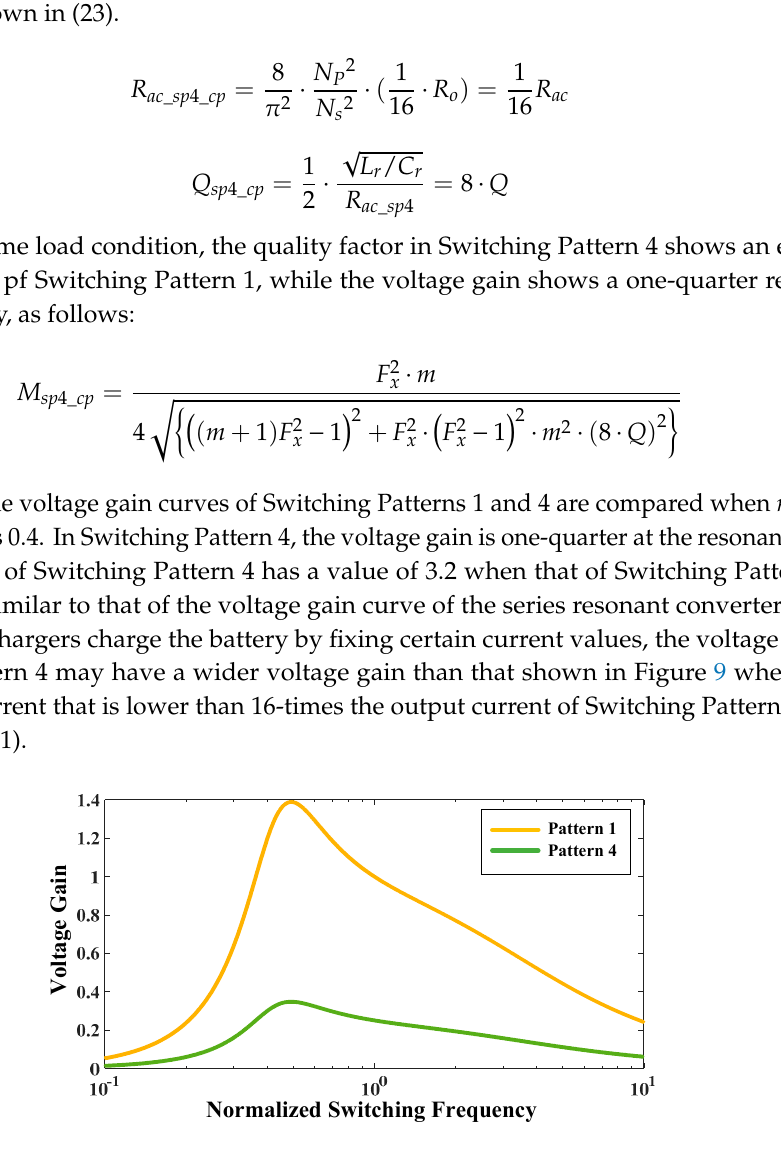
D 3 D 6 Figure 10. Current path of Switching Pattern 5. In the equivalent circuit of Switching Pattern 5, as shown in Figure 11, the magnetizing inductors and resonant inductors in resonance tanks are twice the value of conventional single resonance tanks, while resonant capacitors are half the value. In addition, an equivalent resonant tank is input with twice the input voltage of a single resonant tank. Similar to Switching Patterns 3 and 4, which operate the LLC resonator tanks in series, the Q factor is obtained using the resonance components’ value of the resonant tank in Switching Pattern 5. 2 L m 2 L r V out Figure 11. Equivalent circuit of Switching Pattern 5.